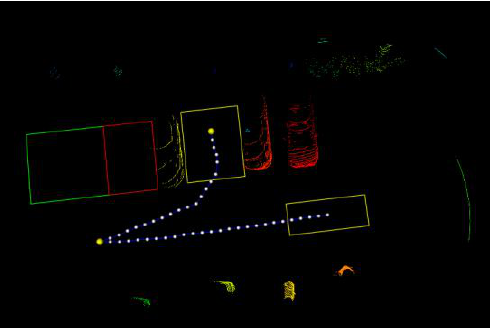
Figure 6. The result of path planning